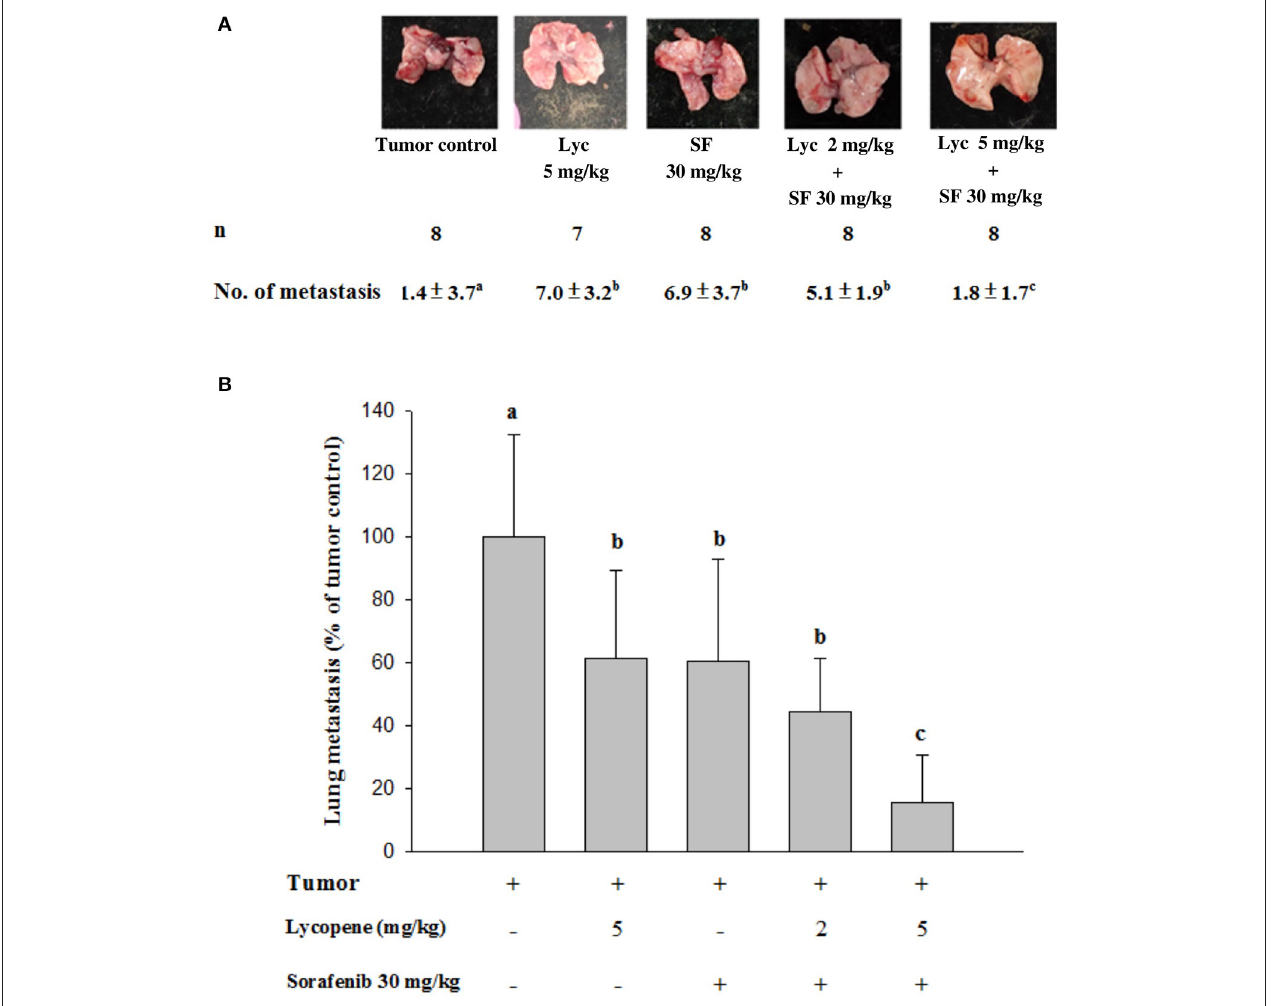
FIGURE 2 | Effects of lycopene (Lyc) alone, sorafenib (SF) alone, or their combination on lung metastasis in the xenografted mice. LLC cells were injected subcutaneously into the right flank of the C57BL/6 mice. Nine days after the tumor cell injection, the mice were orally supplemented with SF (30 mg/kg) daily, Lyc (5 mg/kg) twice per week or the combined treatment (mice were supplemented with SF (30 mg/kg) daily, and Lyc (2 and 5 mg/kg) twice per week) for 28 days. (A) Macroscopic observation of lung metastasis. (B) The quantitative results of the lung metastasis. Data are means ± SD, n = 7 – 8; values not sharing an alphabetic letter are significantly different ( P <